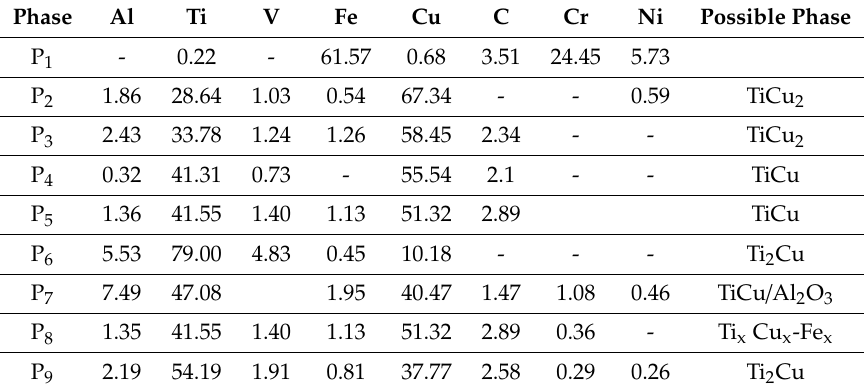
Figure 6. Effect of interlayer composition on joint microstructure during diffusion bonding of Ti–6Al–4V and super-duplex stainless steel. The sample was bonded at 850 °C for 30 min. ( A ) Sample bonded using a Cu/Al 2 O 3 coating electrodeposited onto Ti–6Al–4V; ( B ) Detail of Region 1; ( C ) Sample bonded using 25 µm Cu foil; ( D ) Detail of Region 2. Table 2. EDS assessment of the composition of the joint interface (wt %).